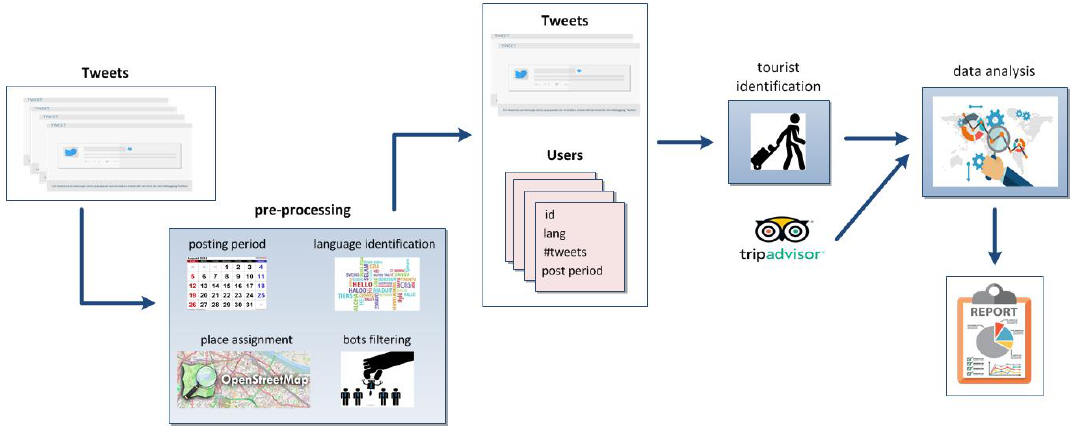
Figure 1. System